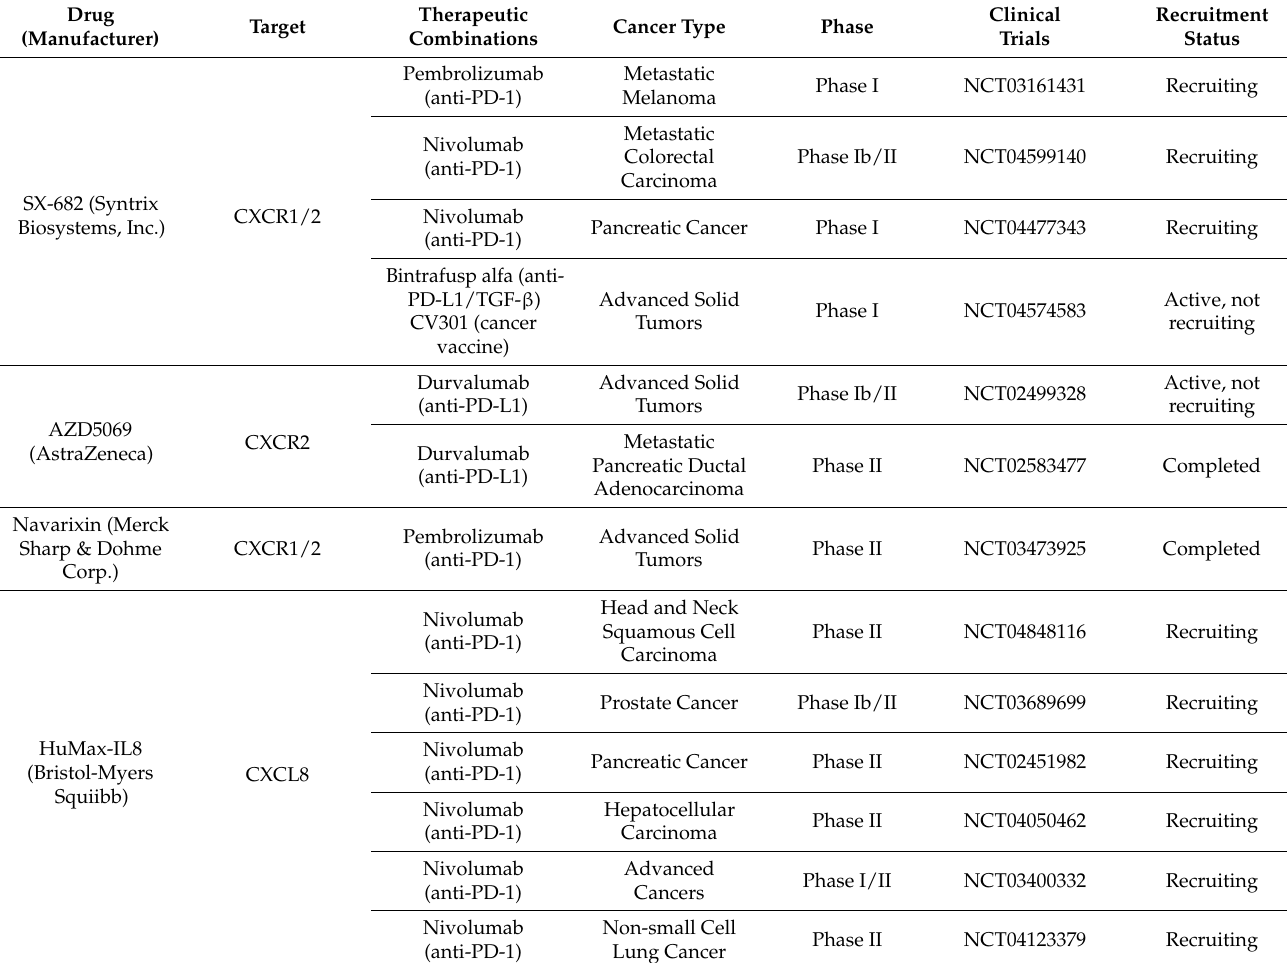
Table 1. Selected clinical trials targeted in CXCL8-CXCR1/2